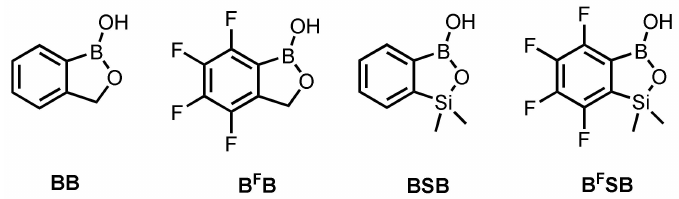
Figure 3. Structures of benzoxa- and benzosiloxaboroles used in computational